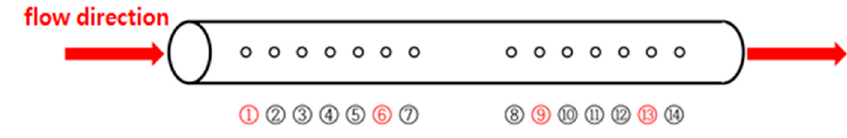
Figure 10. Target irrigation holes.